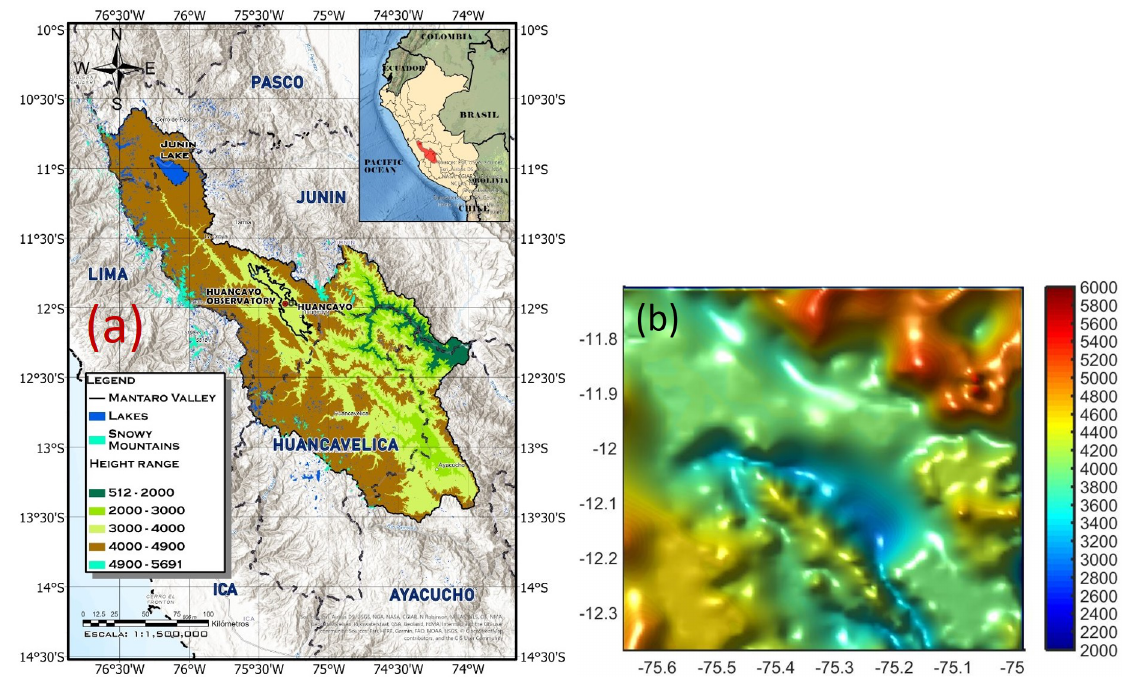
Figure 1. ( a ) The domain of the Mantaro river basin (MRB) and the Mantaro valley (MV). Geopolitical and altitude contours and the location of the HYO are indicated; ( b ) topography around the MV, with higher altitudes close to 5000 m